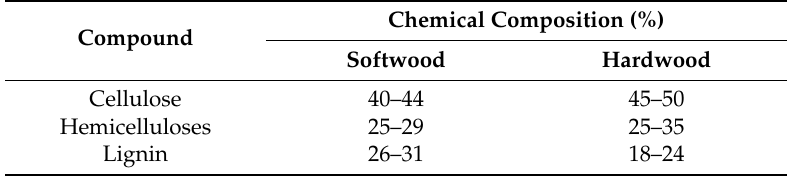
Table 1. Chemical composition of soft- and hardwoods, adapted from